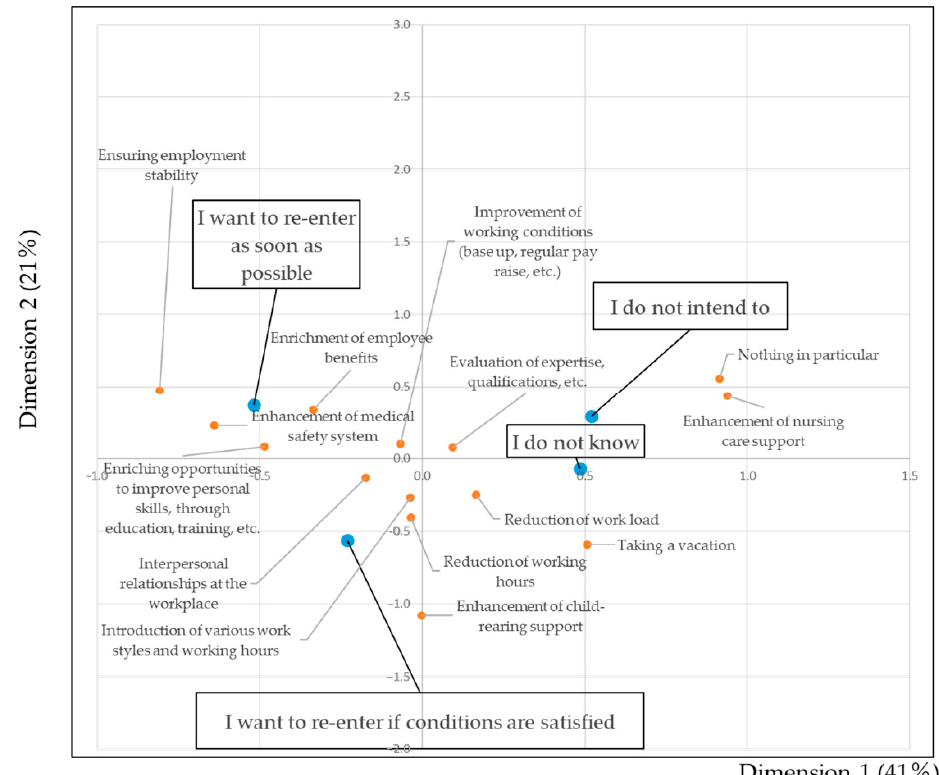
Figure 2. Biplot showing the willingness to re-enter and the need for improvement of the workplace environment. The blue circles show the willingness to re-enter. The red circles show 14 items related to improvement of the workplace environment. The closer the items are, the greater the association between items.